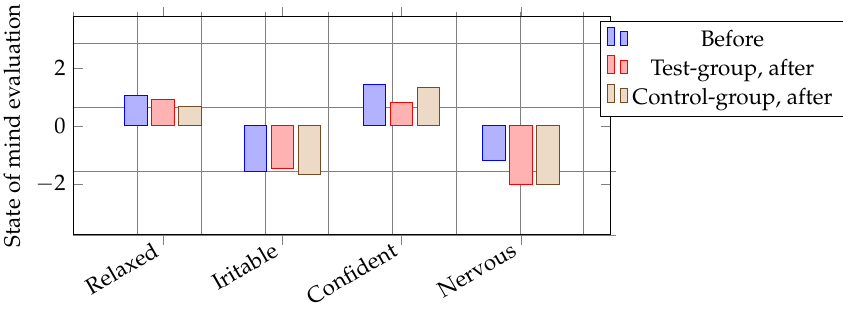
Figure 9. Mean values for responses of the following question, from twenty-one participants at the beginning of the experiment (in blue), for eleven test-group drivers at the emergency stop (red), and three control-group drivers in emergency stop (gray): (1) Do you feel relaxed? (2) Do you feel irritable? (3) Do you feel confident? (4) Do you feel nervous? ( − 2 for strongly disagree, − 1 for disagree, 0 for neutral, 1 for agree, and 2 for strongly agree) (see Appendix